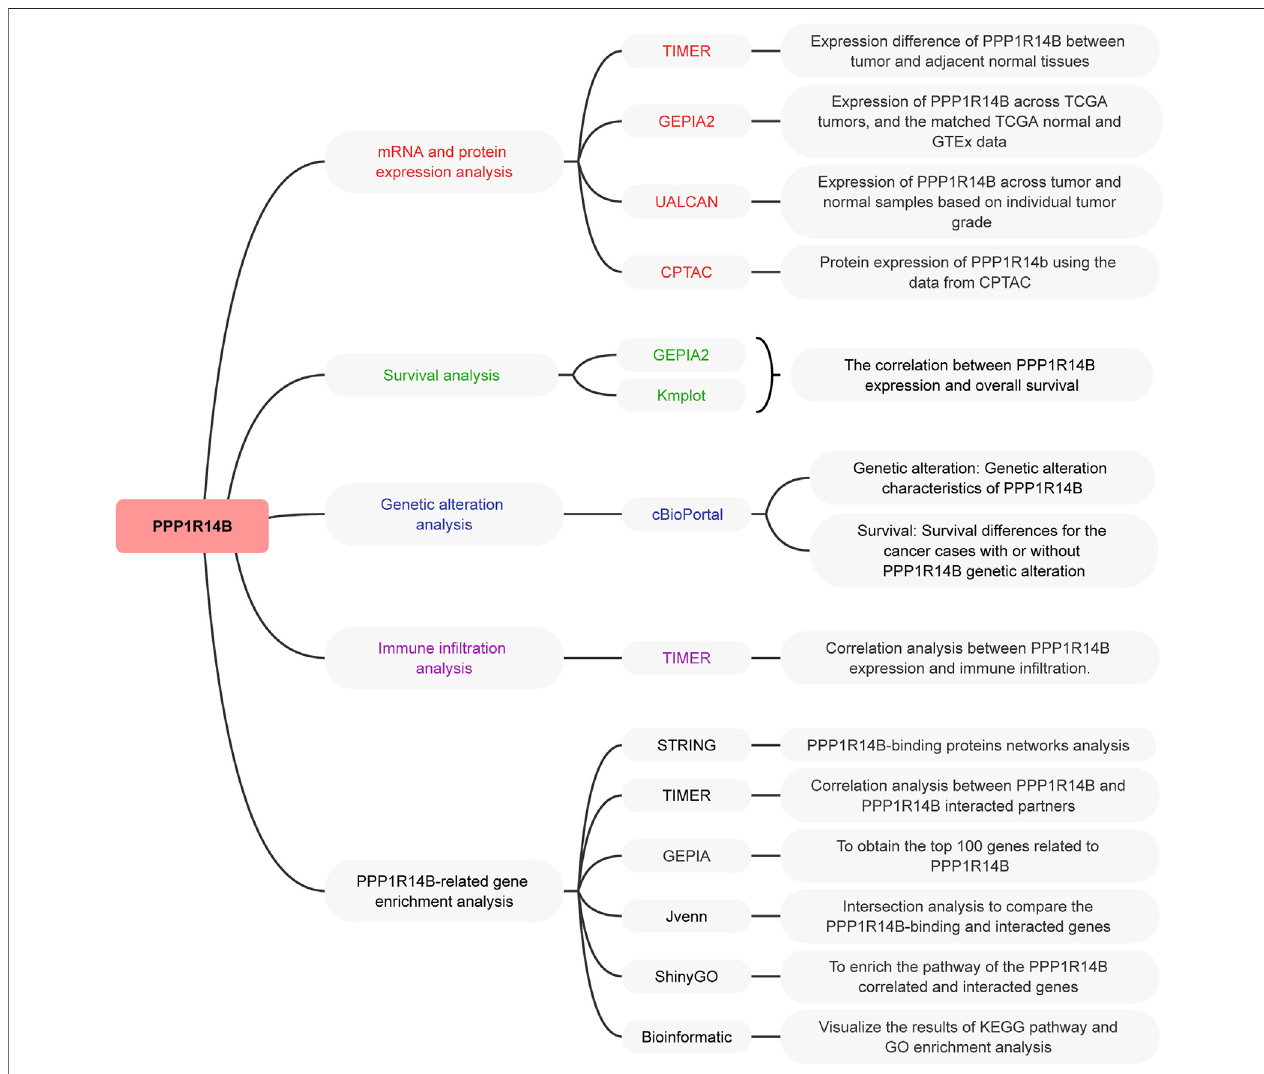
FIGURE 1 | Setup of this study. The TCGA project and GEO databases were used to perform pan-cancer analysis of PPP1R14B.